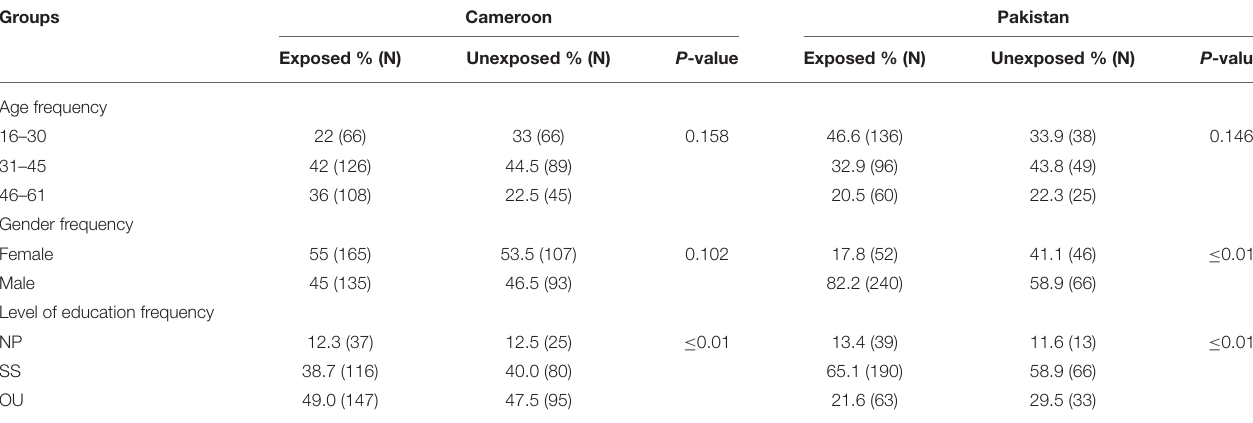
TABLE 2 | Socio-demographic parameters of the study participants. Groups